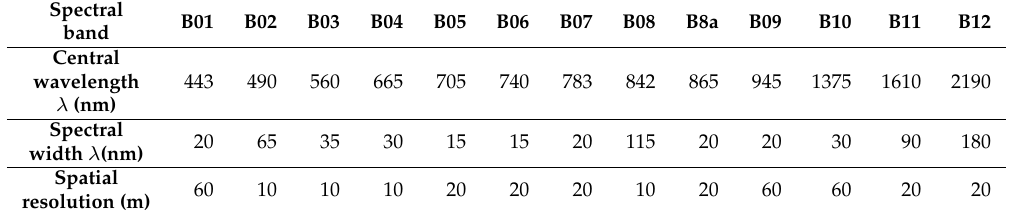
Table 1: Sentinel-2 spectral bands